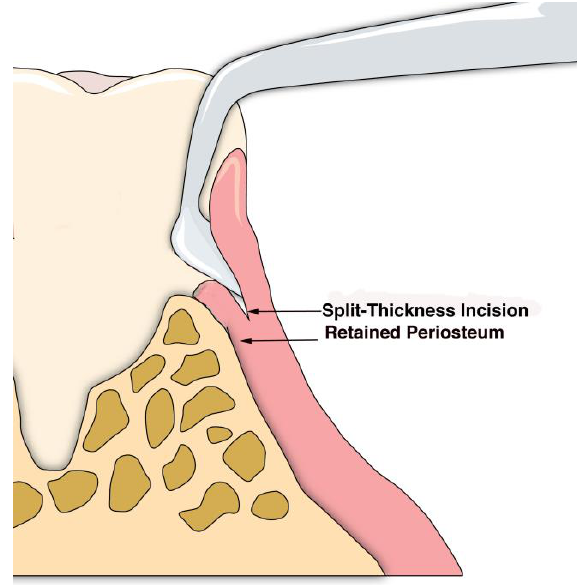
Figure 3. The split-thickness incisions at the base of the papilla (P in Figure 2) are designed to leave the periosteium intact. A periosteal elevator should not be used.